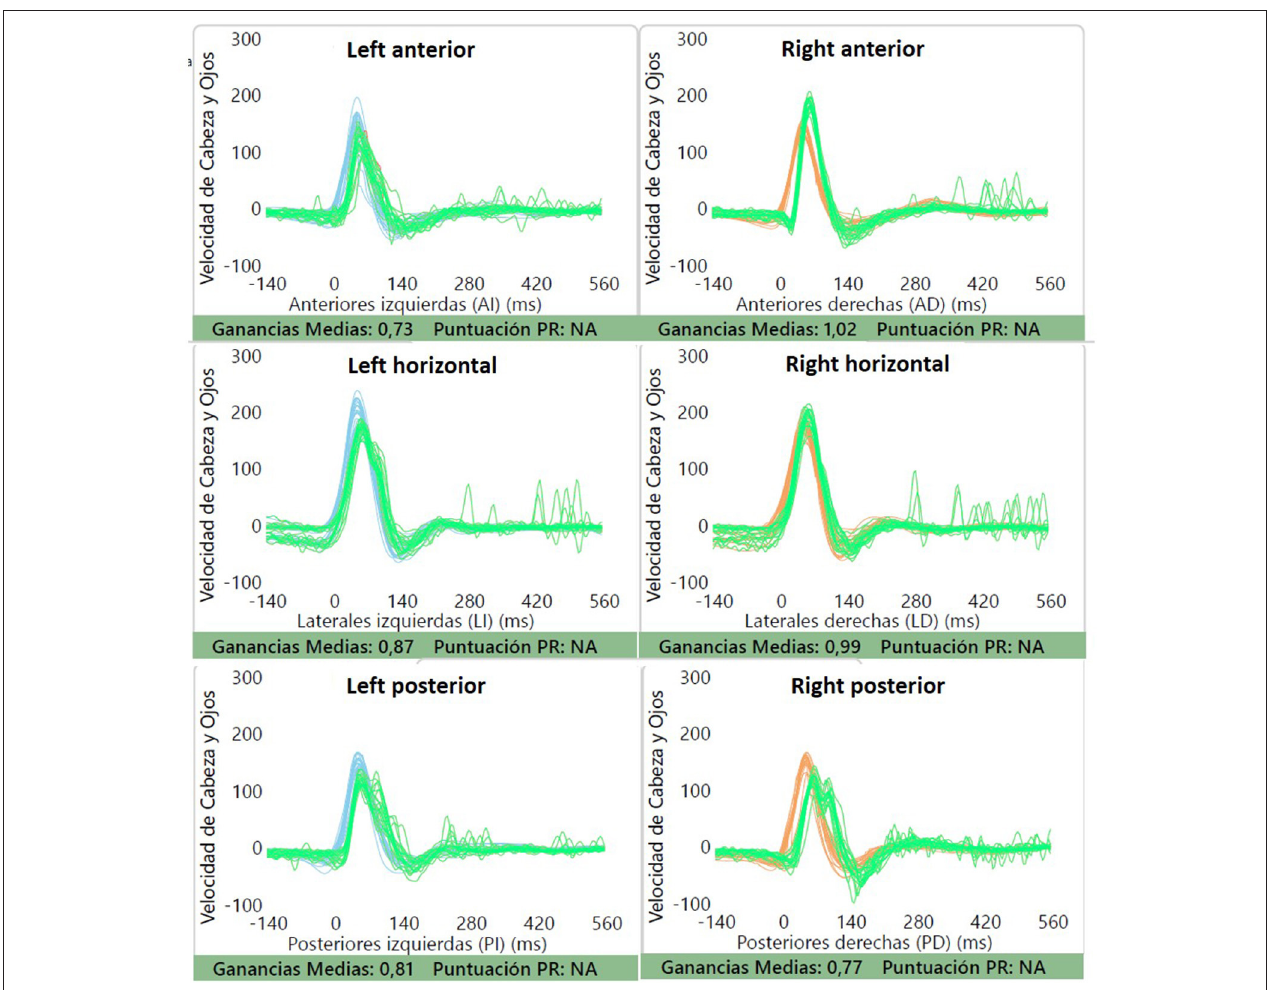
FIGURE 1 | V-HIT testing was normal, with normal VOR gains for all canals and absence of saccades. Gains can be seen for each